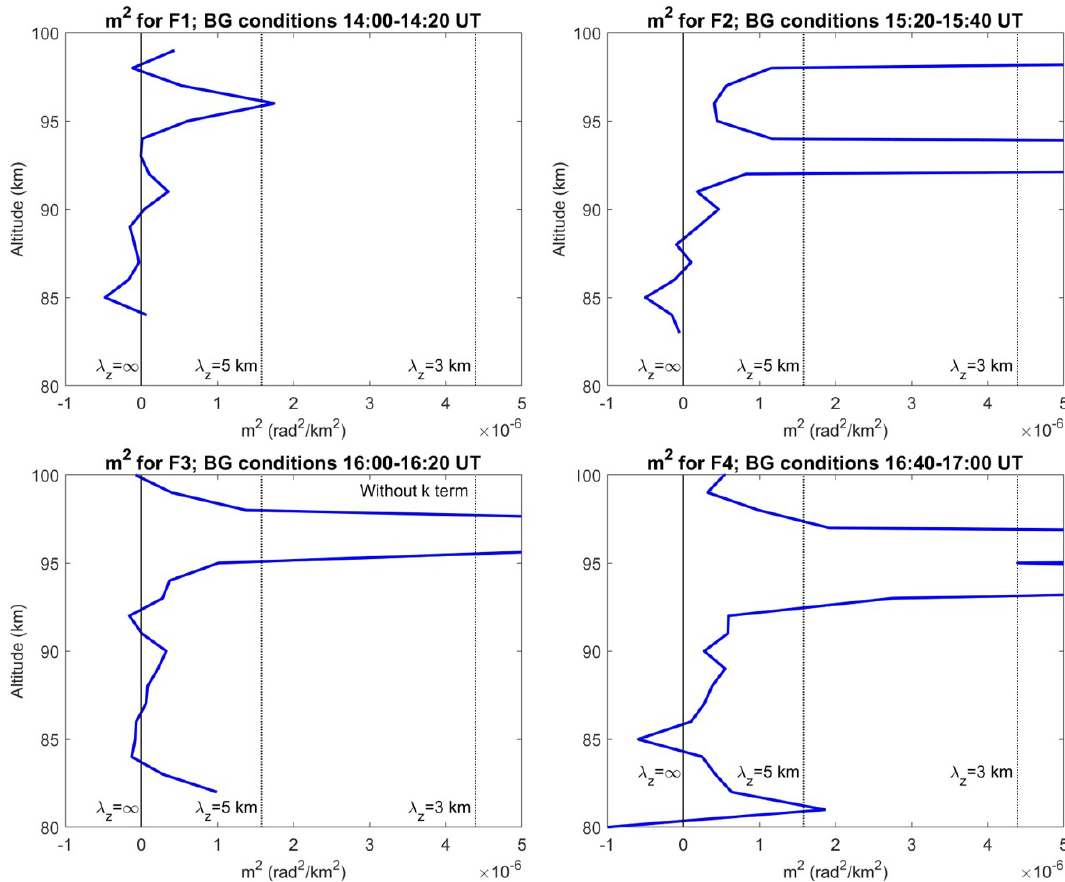
Figure 11. The m 2 profile for the four fronts. Since F3 did not have trailing undulations, its m 2 is calculated leaving the k term in Eq. (4). The solid vertical line shows the 0 value, and the dotted vertical lines show m 2 values corresponding to 5 and 3km vertical wavelengths.